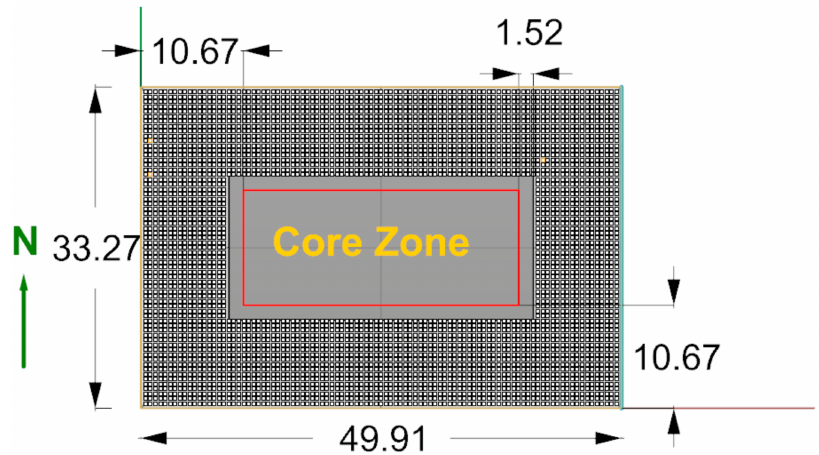
Figure 2. Model setup for daylight simulation with analysis grid: plan view (core zone is the space inside the red